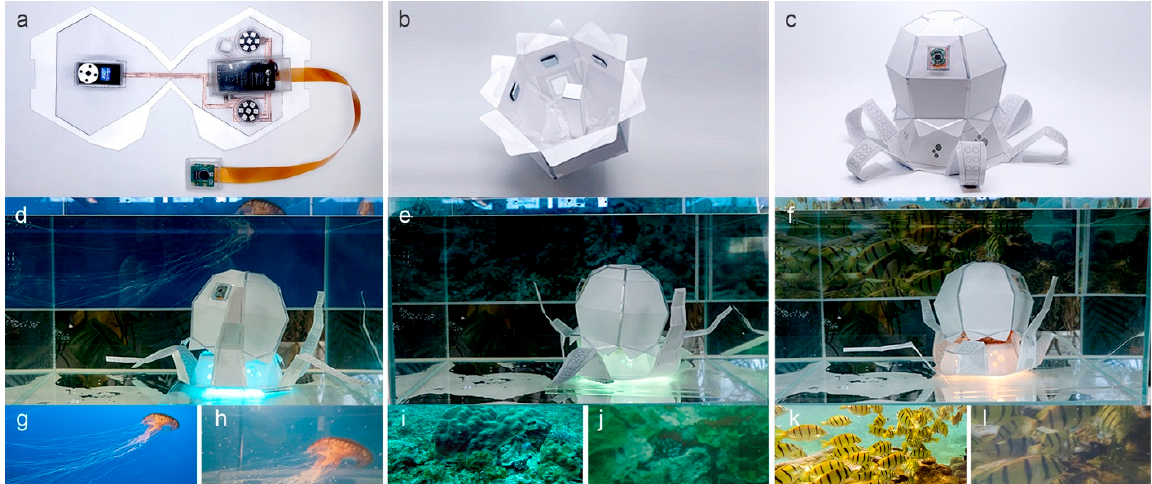
Figure 17. Underwater camera: ( a ) paper circuit of Octopus; ( b ) folded paper prototype with a rigid structure and counterweights; ( c ) appearance of Octopus; ( d – f ): Octopus can recognize the color of its surroundings to change its body’s color; ( g , i , k ) are posters with different colors, placed on the outside of the tank; and, ( h , j , l ) are photos taken by the robot.